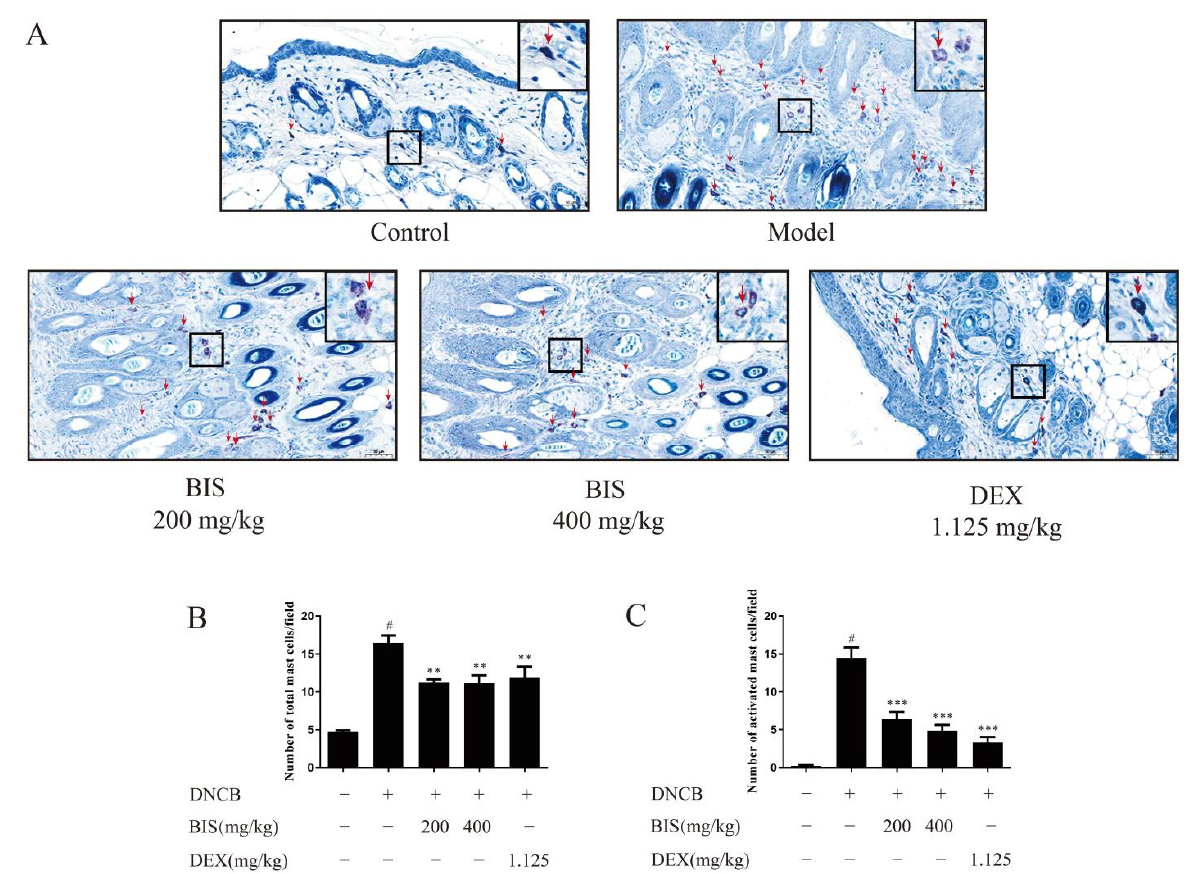
Figure 4. Effect of BIS on mast-cell infiltration and degranulation. DNCB-induced dorsal skin was detected by toluidine blue staining. ( A ) Representative images of skin sections. Red arrow indicated individual mast cell. The number of total mast cells ( B ) and activated mast cells ( C ) were counted of skin sections. Magnification: × 200. Scale bar = 50 µ m. Data represent the mean ± SEM, n = 5 mice/group. # p < 0.05 vs. Control; ** p < 0.01, *** p < 0.001 vs. Model.